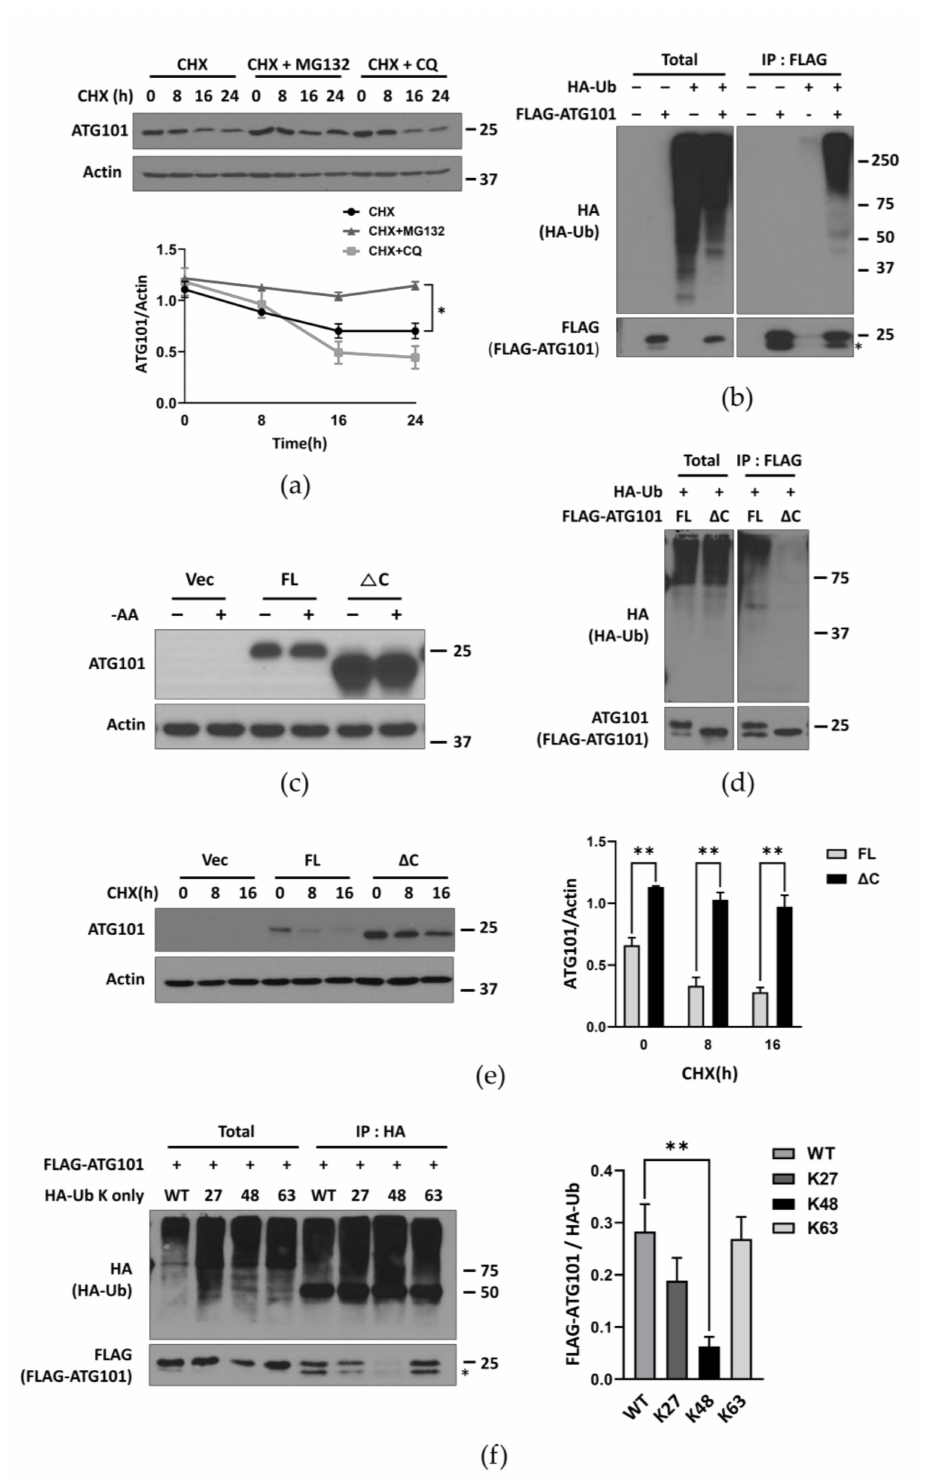
Figure 2. Ubiquitination of ATG101 is regulated through the C-terminal domain. ( a ) Cellular ATG101 is degraded primarily via the proteasomal pathway. MIA PaCa-2 cells were plated overnight and incubated with the protein synthesis